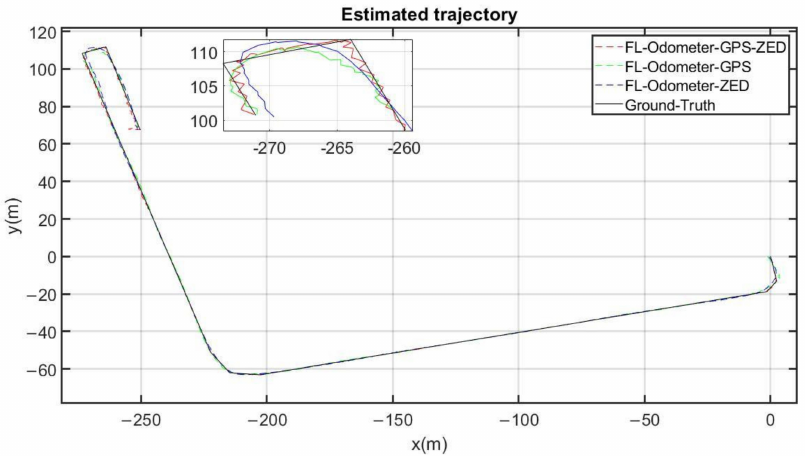
Figure 9. The different three fuzzy system outputs on the same graph. In red, the Odometer-GPS-ZED FL system output is plotted; in green, the Odometer-GPS FL system output is drawn; in blue, the Odometer-ZED FL system output is illustrated, and the ground truth can be seen in black.